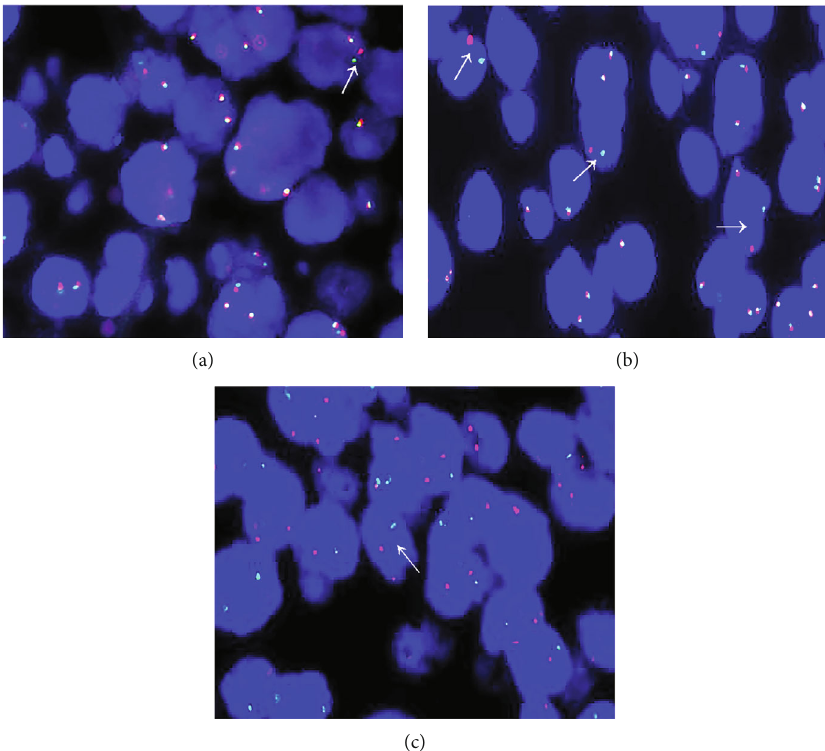
Figure 5: Representative FISH fi ndings in patients with B-cell lymphoma. (a – c) Shows Bcl-2, Bcl-6, and MYC rearrangements. FISH: fl uorescence in situ hybridization ( ×